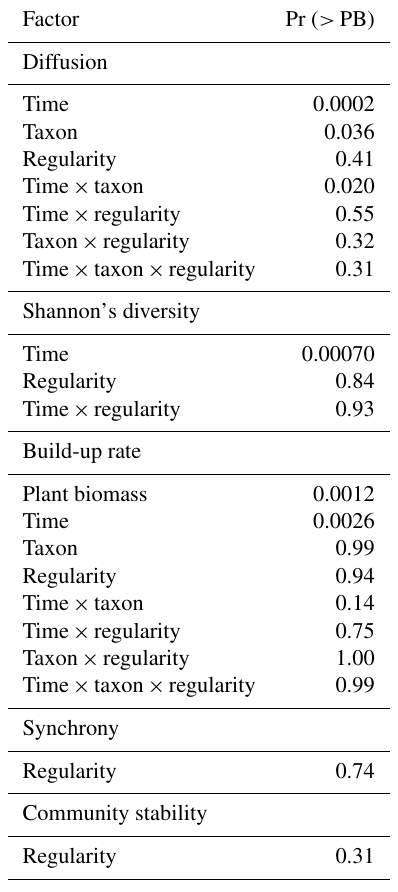
Table 1. Effect of time, soil fauna functional group, and regularity of the plant spatial network (lower values indicate more clustered configurations) on soil fauna diffusion; effect of A. stolonifera plant biomass per mesocosm, time, soil fauna functional group, and plant regularity on soil fauna population build-up rate; effect of plant reg- ularity on soil fauna community synchrony and stability; effect of time and plant regularity on soil fauna Shannon’s diversity. P values were calculated based on parametric bootstrap type III